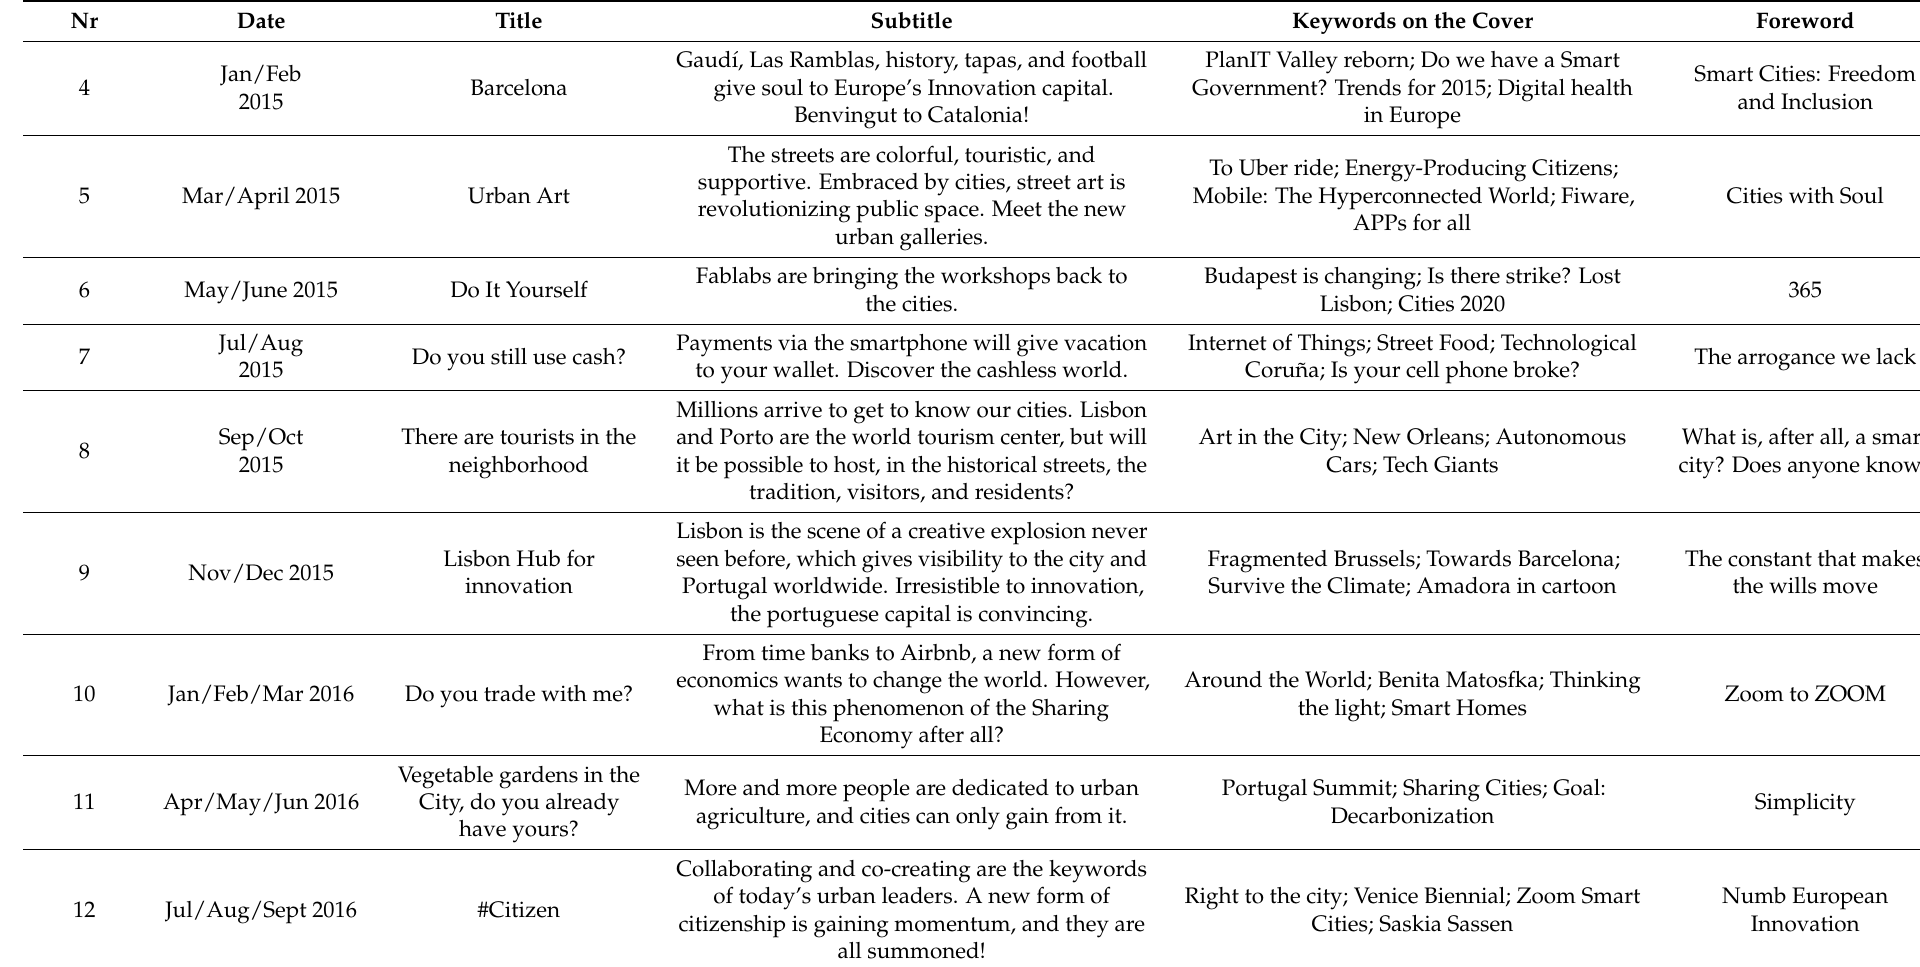
Table A1. Smart City Magazine